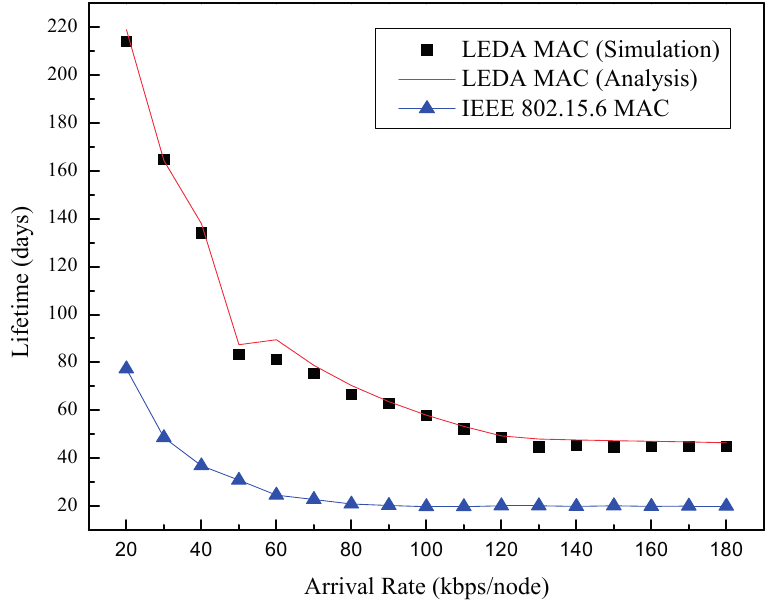
Figure 18. Lifetime of network vs . arrival